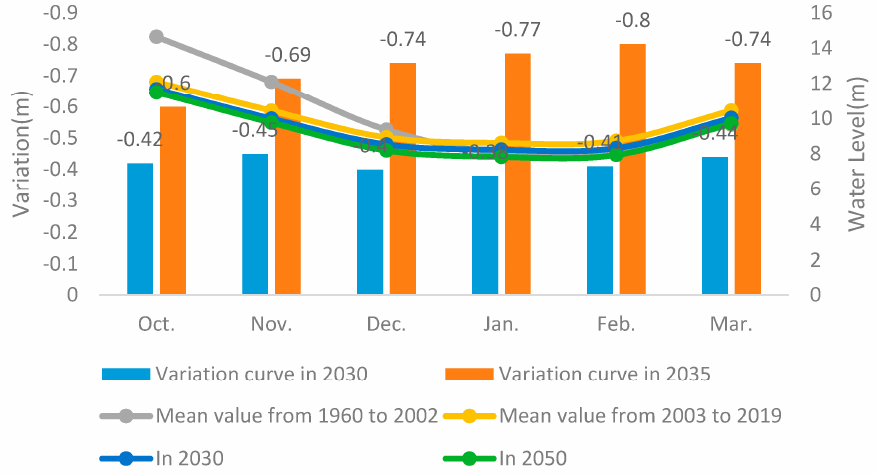
Figure 13. Analysis of the monthly variation curve of the average water level at Hukou hydrometric station during the dry season.